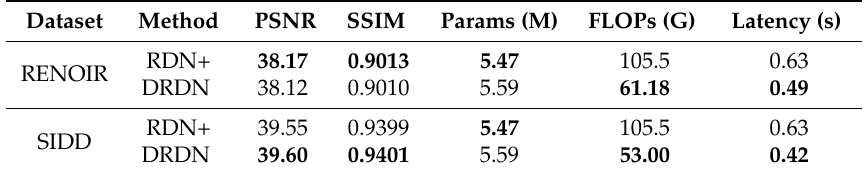
Table 1. Results of real-world denoising on the RENOIR [27] and the SIDD [28]. Best performance is in